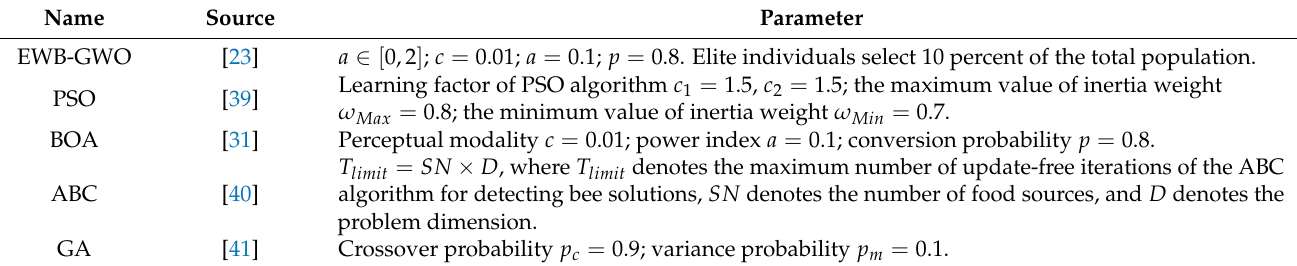
Table 6. The parameter setting of each algorithm.